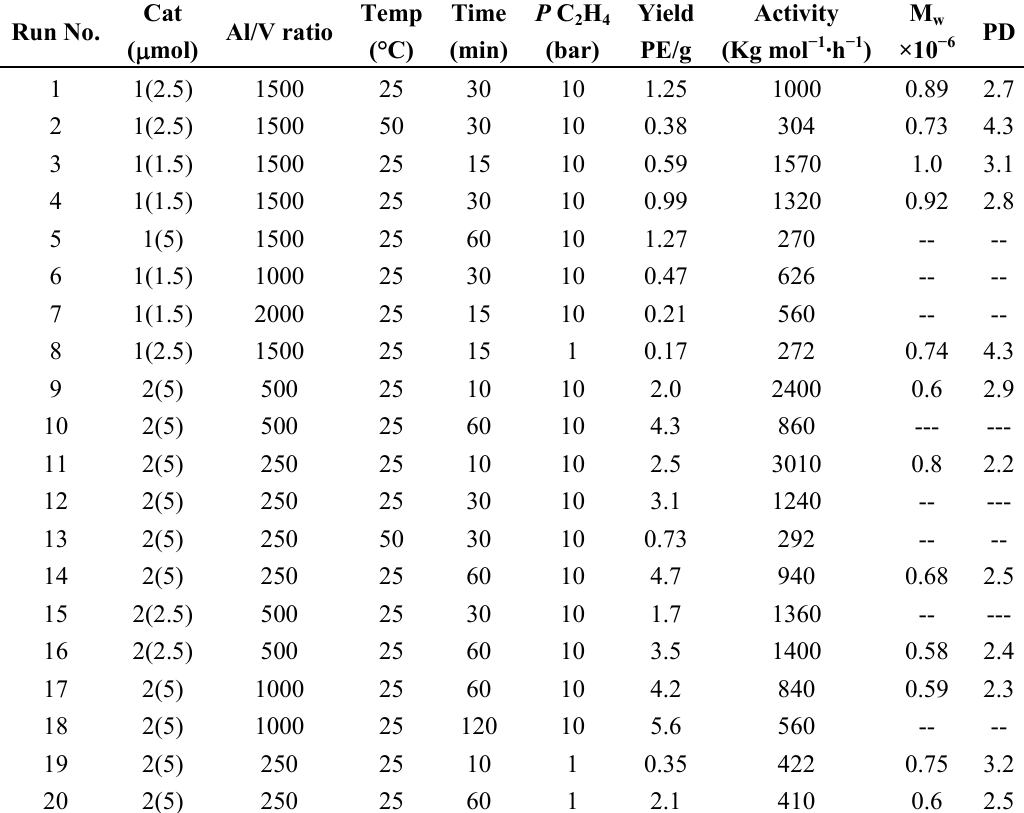
Table 2. Polymerization of ethylene using precatalysts 1 and 2 . Run